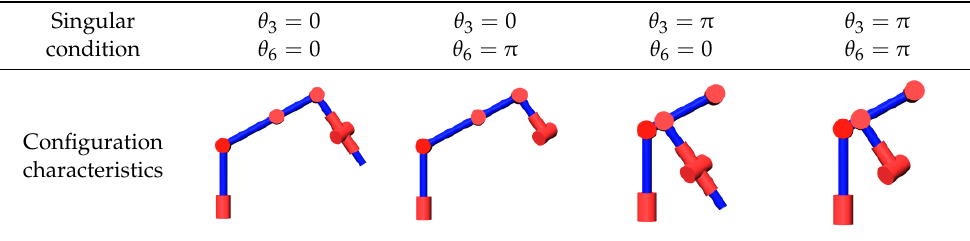
Table 3. Singularities corresponding to condition 1.